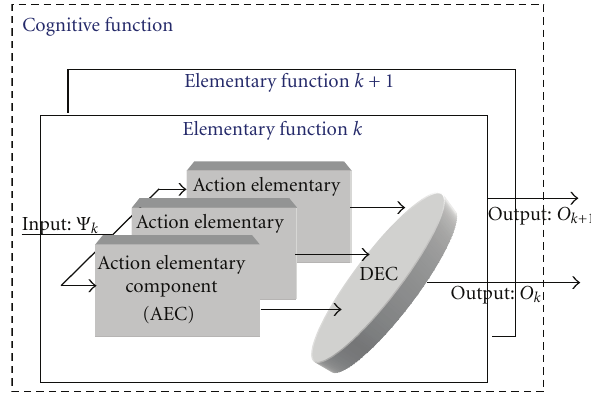
Figure 2: General bloc diagram of a cognitive